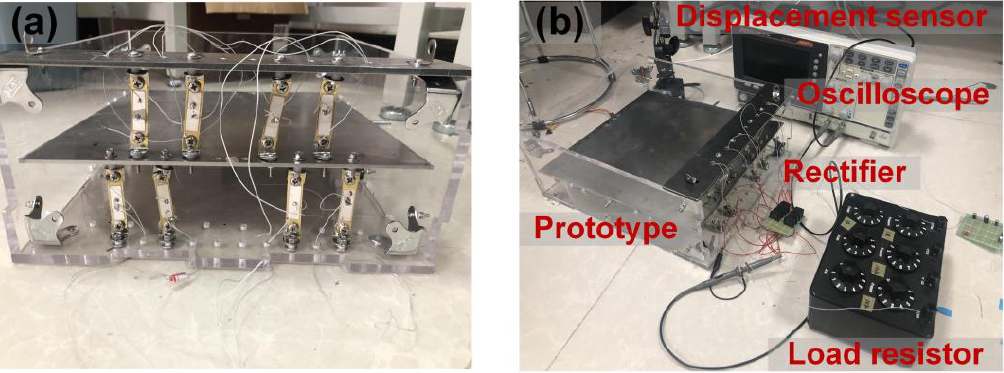
Figure 7. ( a ) The photo of the manufactured prototype; ( b ) the instruments for the experiment.